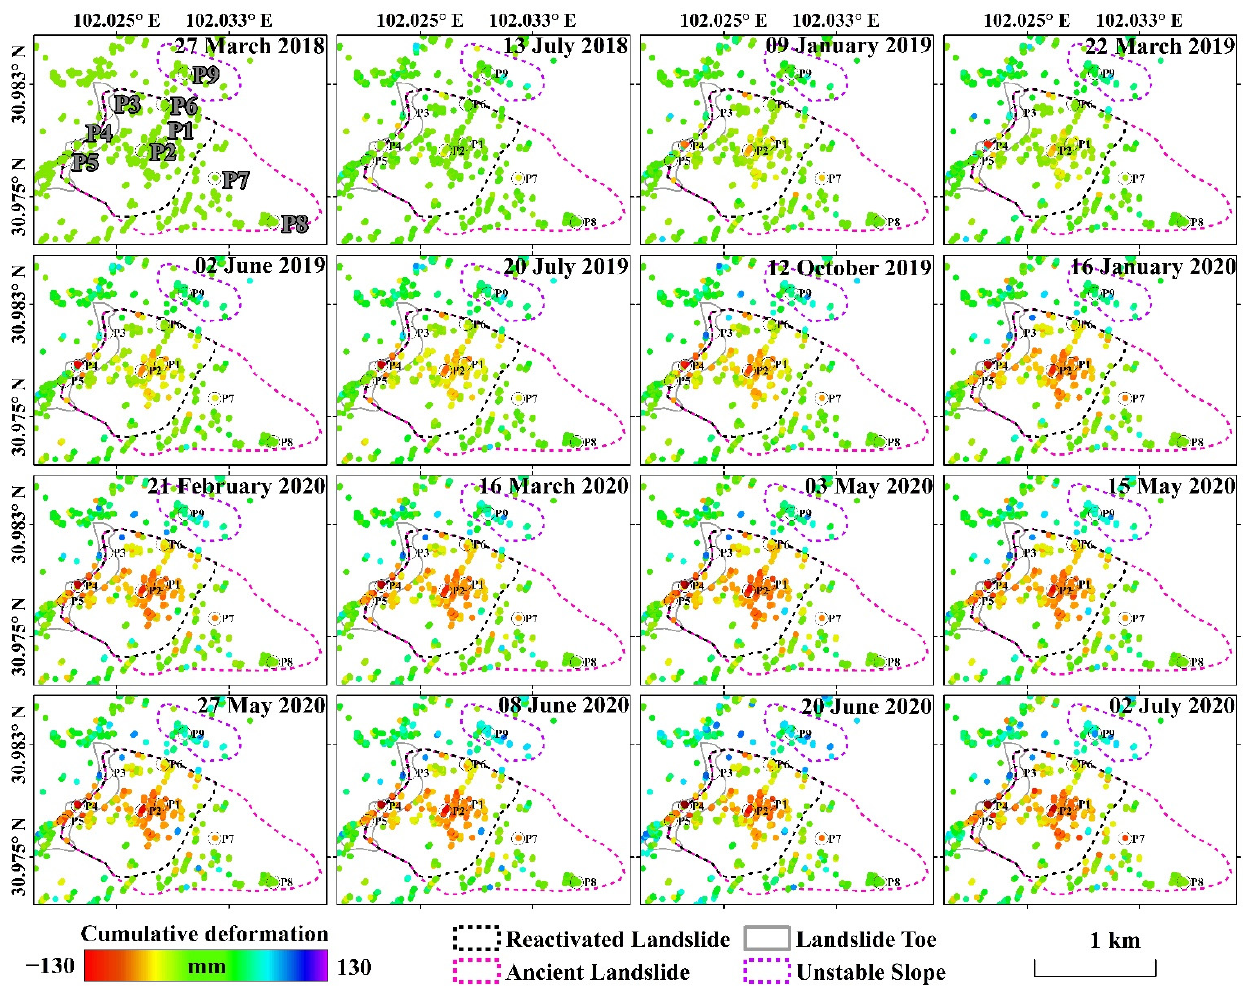
Figure 11. Descending cumulative LOS deformation of the measurement points located at the Aniangzhai slope for the 16 selected acquisition dates of Sentinel-1 descending datasets, referring to the first SAR image acquired on 27 March 2018. It is noted that a recently published work [70] found a clear acceleration over the upper